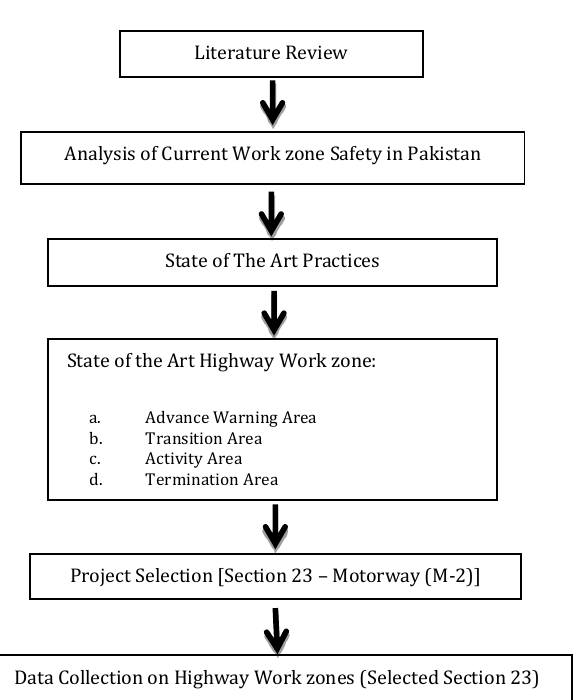
Figure 1. Research